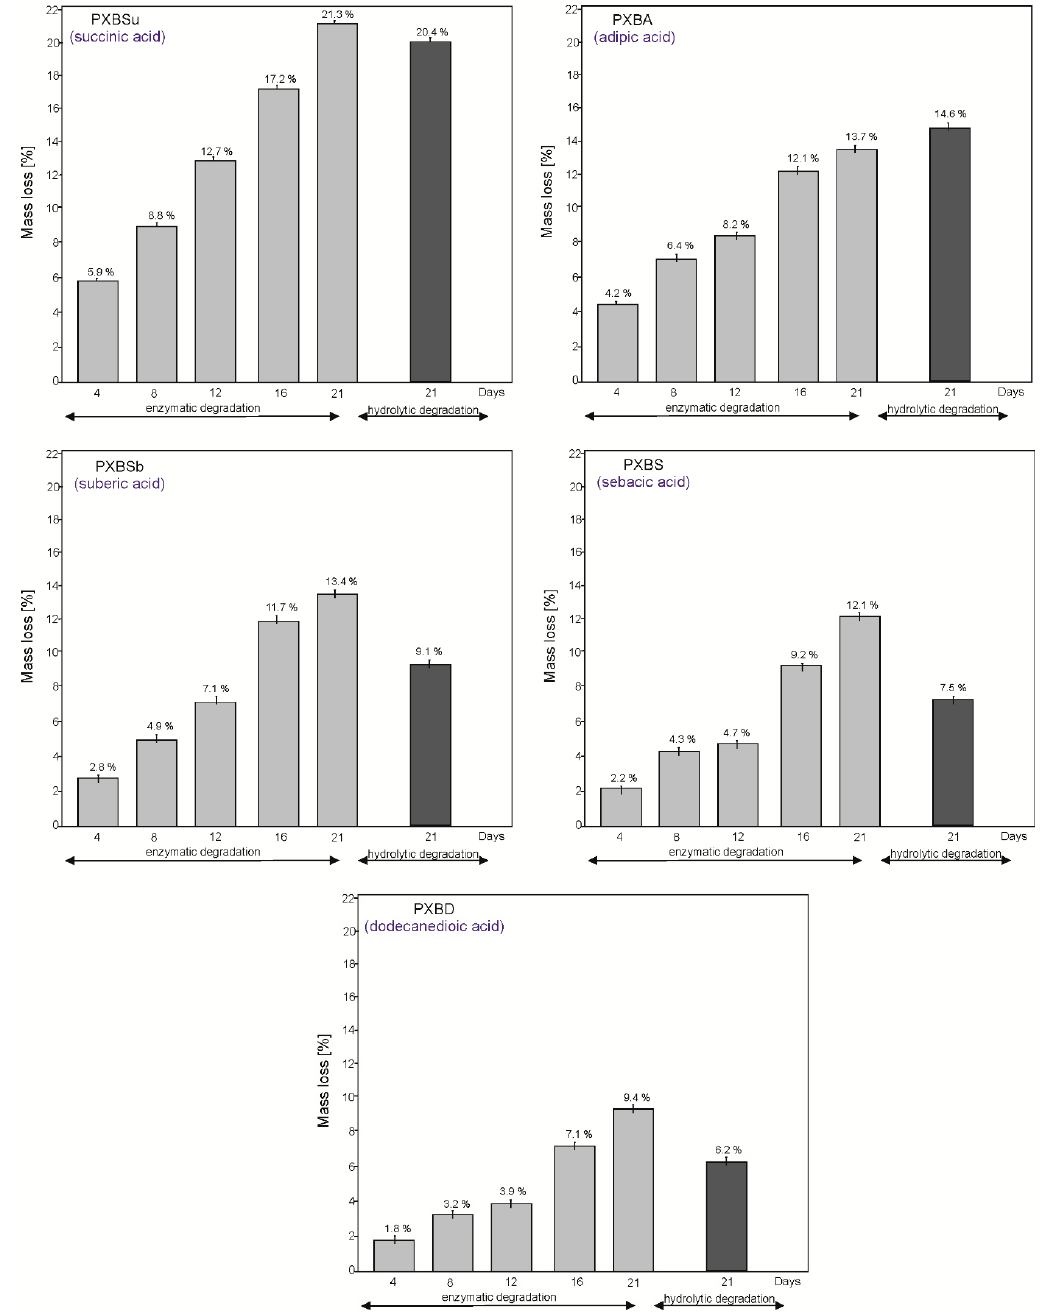
Figure 12. Hydrolytic and enzymatic degradation of PXBSu, PXBA, PXBSb, PXBS and PXBD